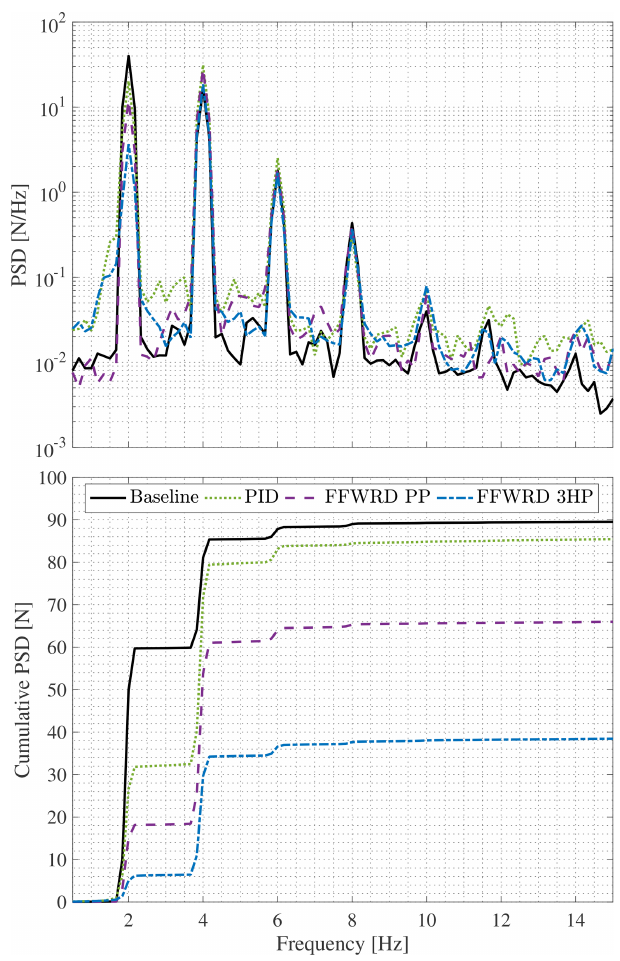
Figure 21. PSD and CPSD of the lift amplitude for the inflow dis- turbance with a base frequency of k = 0 .